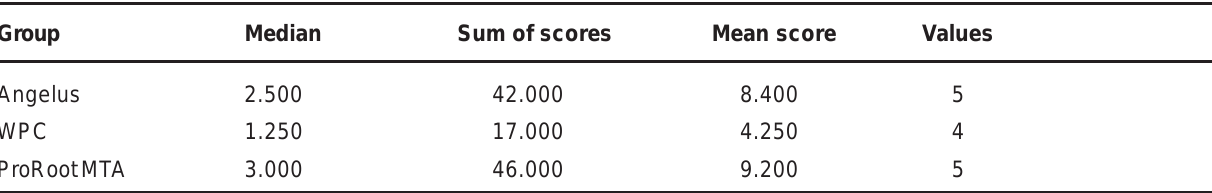
Hc= 3.664733 Exact probability = 0.162354 Chi-square at 2 degrees of freedom Probability = 0.160034 Study groups without statistical difference